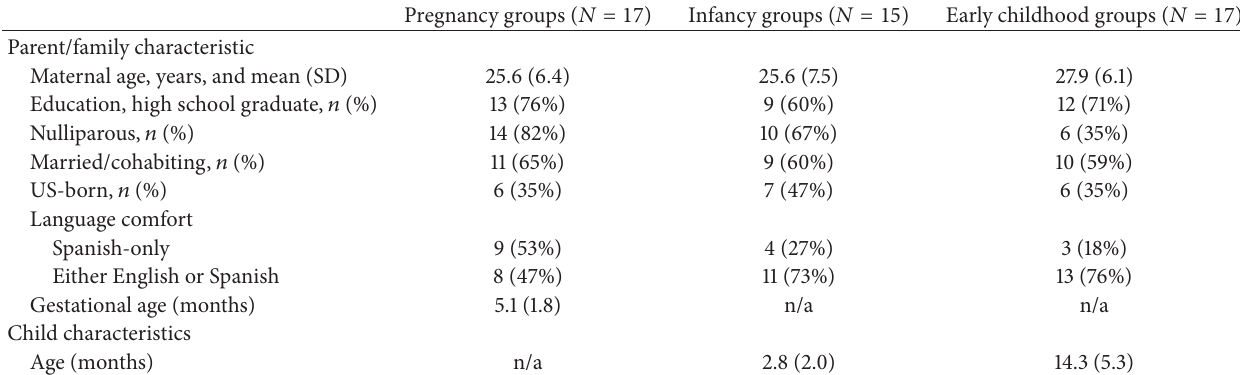
Table 2: Mother and child characteristics according to focus group discussion participation. Data from 49 Hispanic